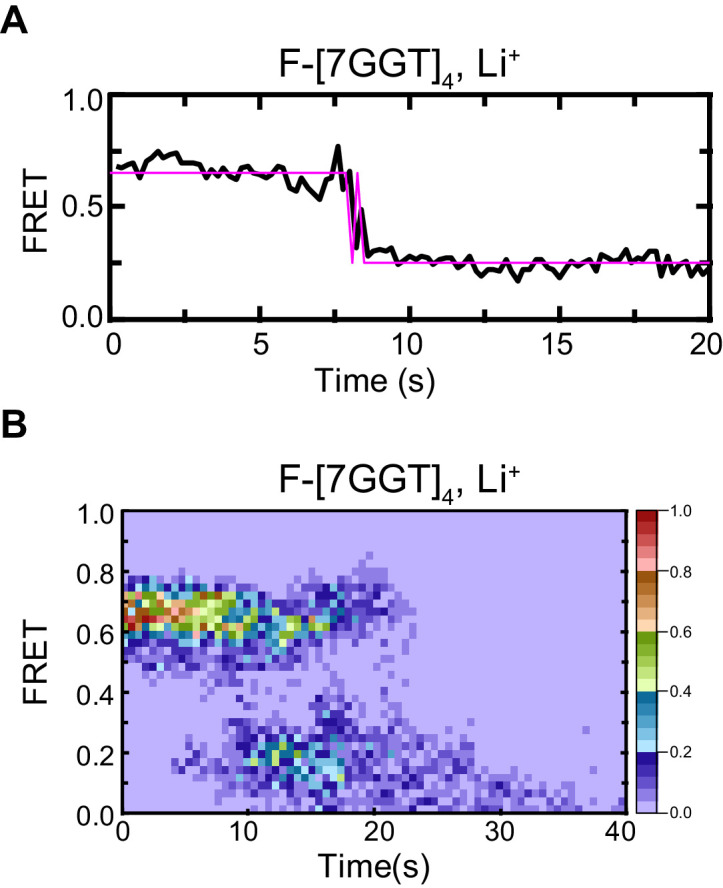
Control demonstrating G4 origin of ~0.5 FRET value of F-[7GGT]4.Representative FRET trace (A) and heat map of the distribution of FRET intensities (B), n = 52) of F-[7GGT]4, surface immobilized in KCl-containing buffer, which was replaced with LiCl-containing buffer after 5 s.